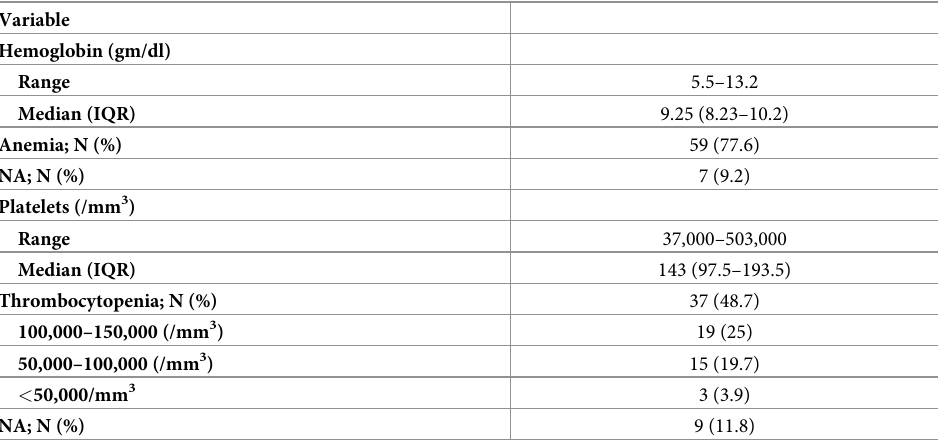
Table 2. Hematological findings in 76 hepatorenal tyrosinemia